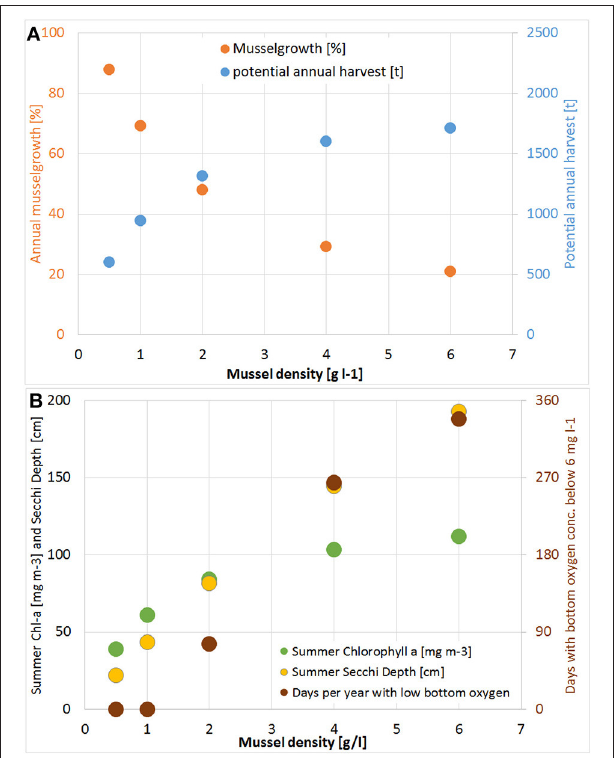
FIGURE 5 | Observed and modeled values for Chlorophyll a ( A ; mg m − 3 ) and Secchi Depth ( B , m) at station KHO (near Ueckermünde). Observation provided by the State Agency for Environment, Nature Conservation and Geology